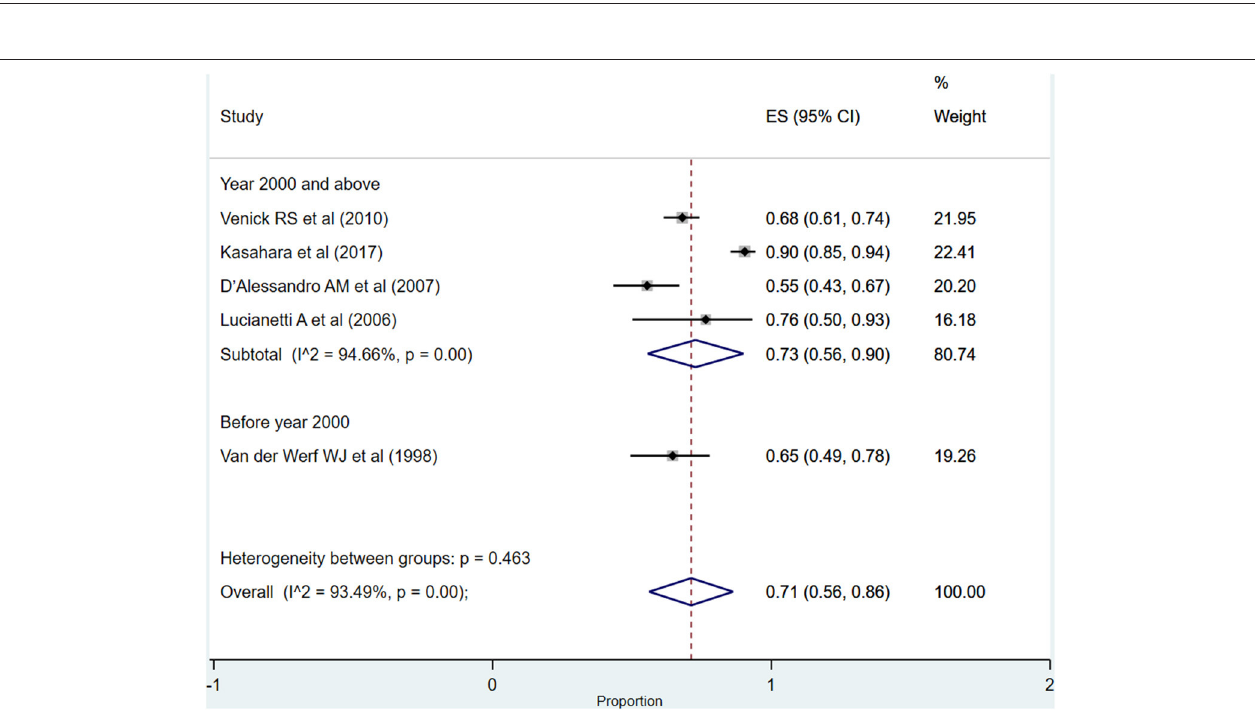
FIGURE 7 | Pooled graft survival rate among infants at more than 5 years post-liver transplantation.